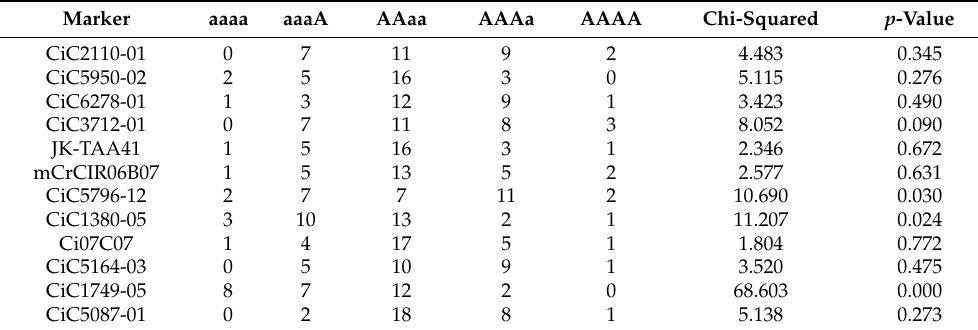
Table 4. Analysis of tetrasomic random allelic segregation of the tetraploid recovered plants from the self-pollinated flowers of the tetraploid ‘Clemenules’ clementine. Marker aaaa aaaA AAaa AAAa AAAA Chi-Squared p -Value CiC2110-01